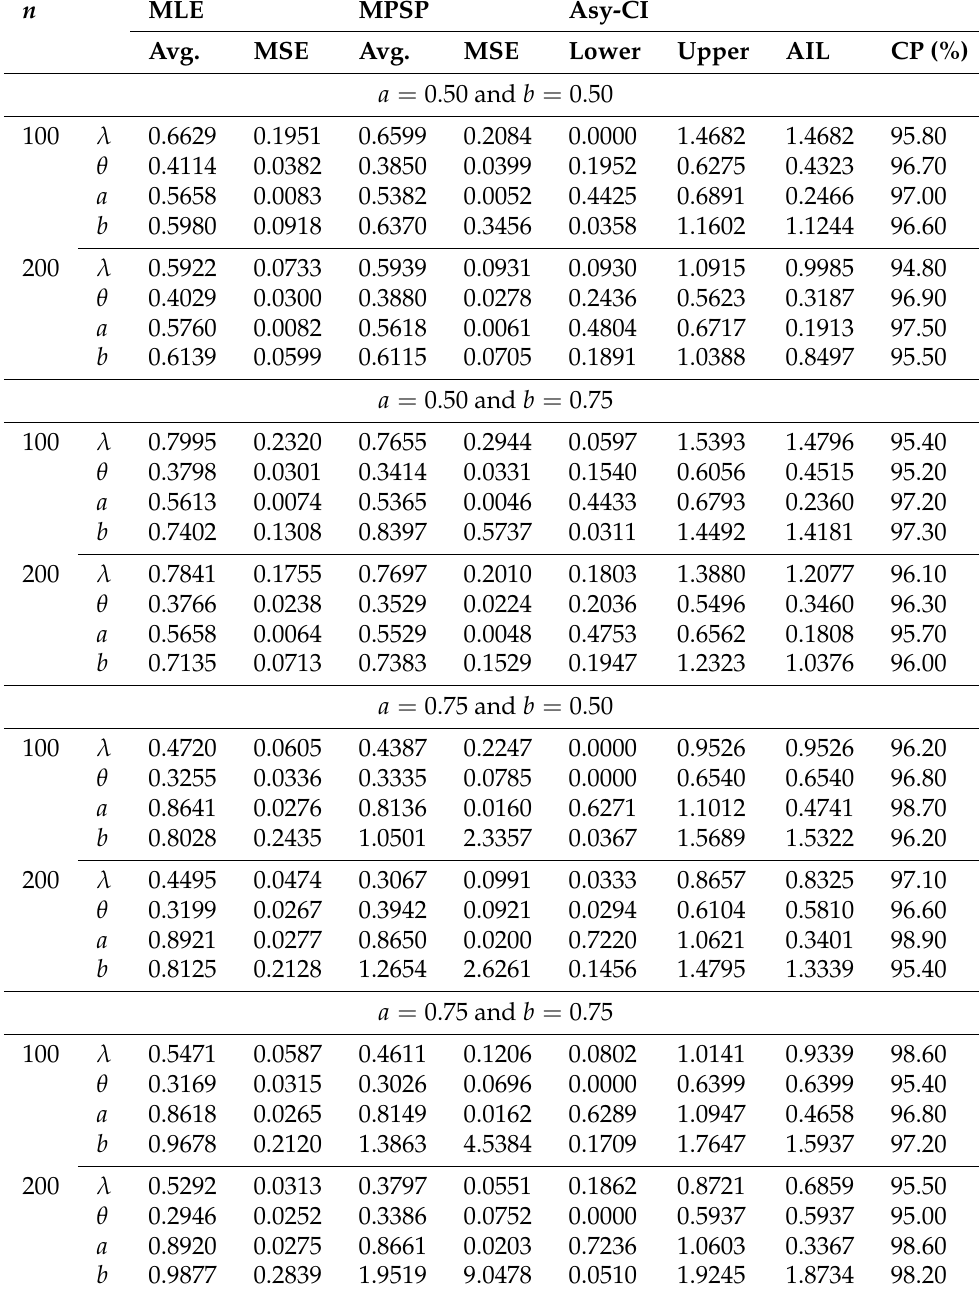
Table 5. Avg. estimated values, MSEs, Asy-CI, AILs and CP (in %) of Non-BE (MLE and MPSP) for the BBE 2 distribution at different sample sizes n and different values of ( a , b ) when λ = 0.50, θ =